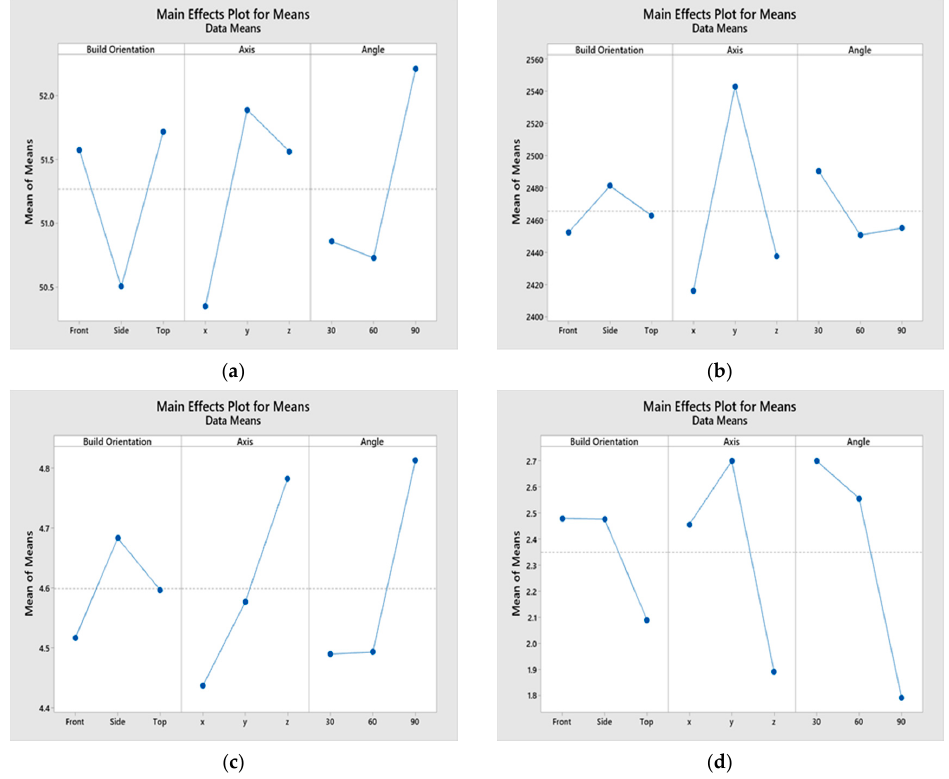
Figure 14. Main effects plot for ( a ) UTS, ( b ) modulus of elasticity, E, ( c ) percent elongation, and ( d ) surface roughness, Ra using Taguchi analysis.